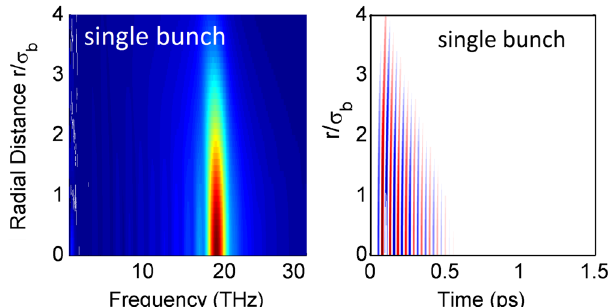
FIG. 9. Spectral and temporal distributions of the undulator emission for the reversed (deliberately wrong) orientation of − z Þ optimal tapering, f opt u ð L u